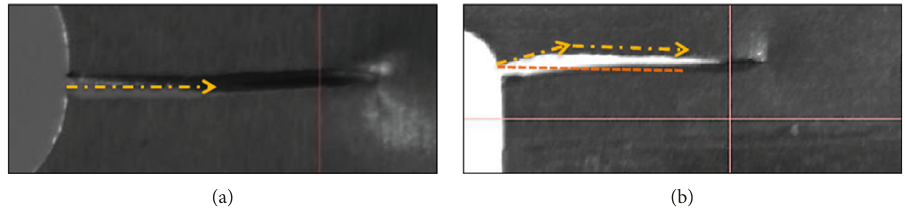
Figure 11: Fatigue crack growth direction of (a) notches; (b)